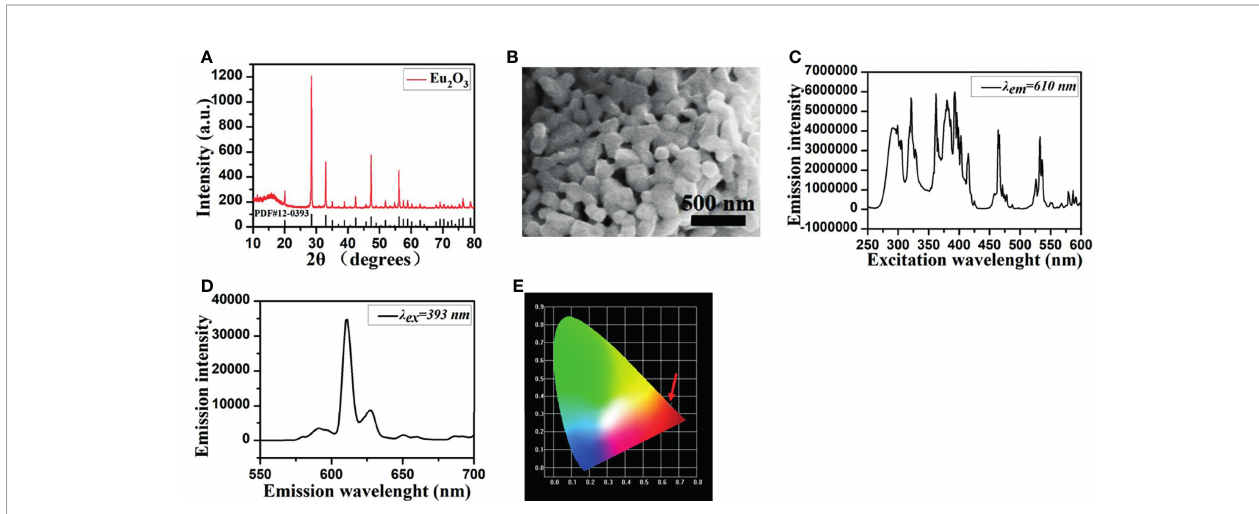
FIGURE 1 | EO nanoparticle morphology and characterization. (A) XRD patterns of EO. (B) SEM visualization. (C) The optical excitation spectrum with 610 nm exhibits the characteristic absorption peaks at 292, 321, 362, 380, 393, 464, and 533 nm. (D) The emission spectra of EO excited by 393 nm. (E) CIE chromaticity diagram of